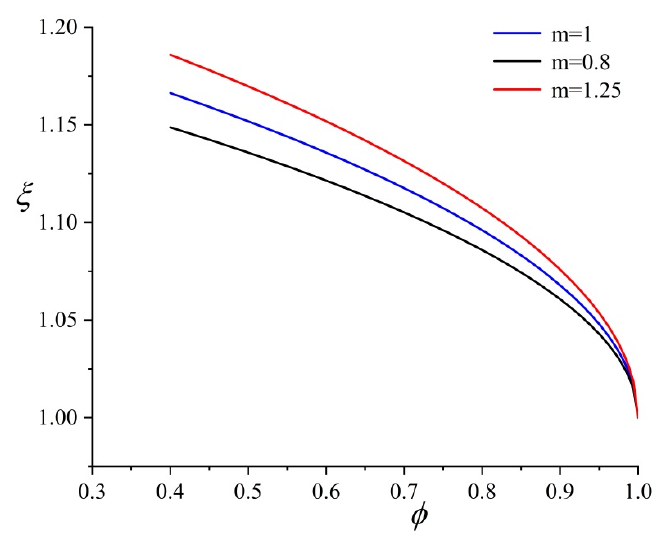
Figure 7. Influence of different values of m on tortuosity.